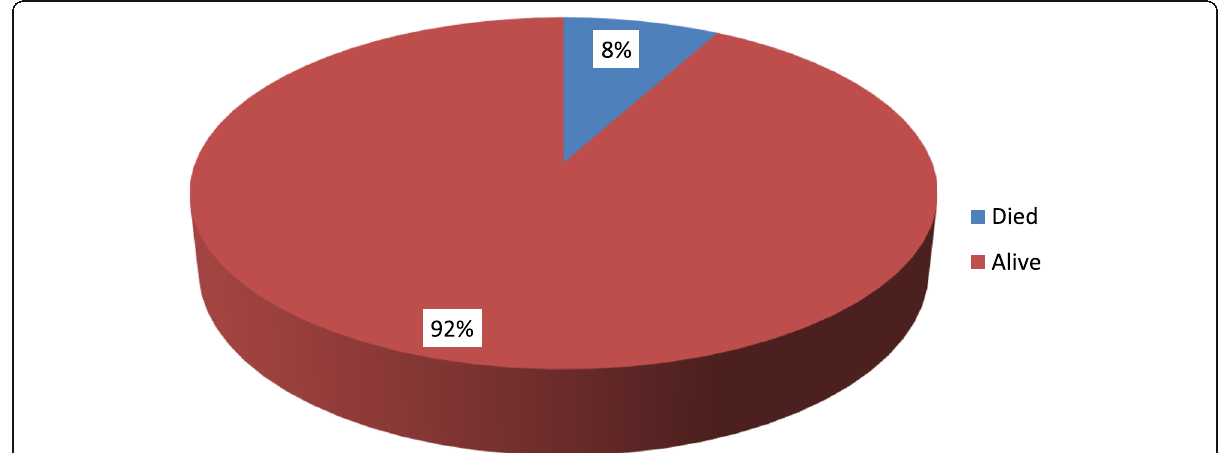
Fig. 2 Outcome of patients in the current